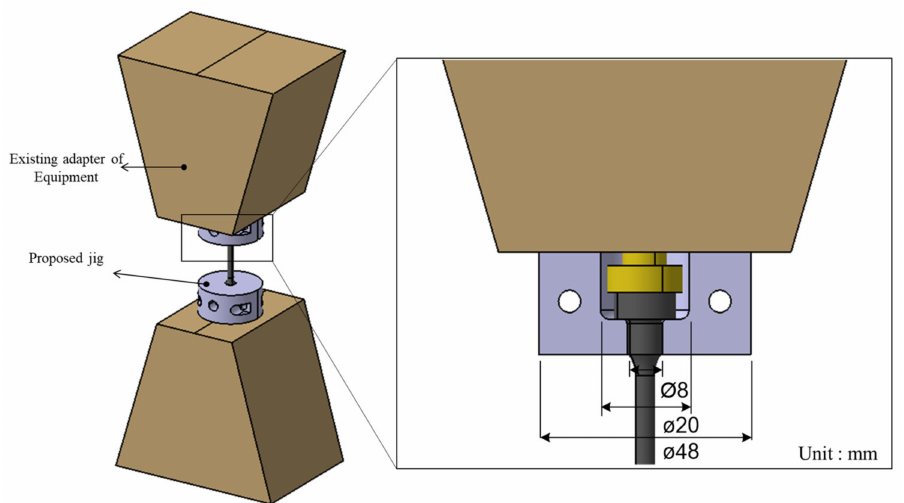
Figure 3. Dimensions of the proposed jig for high-strength tensile tests combined with the existing adapter of the